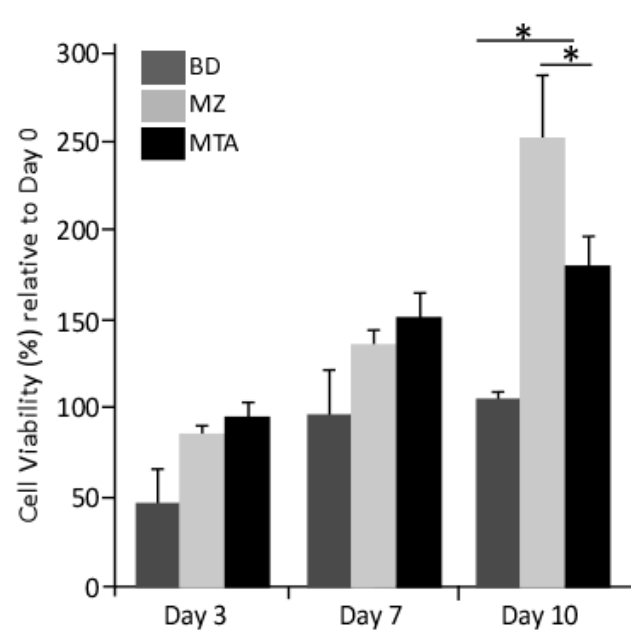
Figure 2. Proliferation MTT assay. The data were represented as the average ± SD ( n = 3) versus cells cultured on control media. Average of the MTT absorbance in the 3 experimental groups and the control. There are significance differences between BD and MZ and between BD and MTA. (* : p < 0.01).